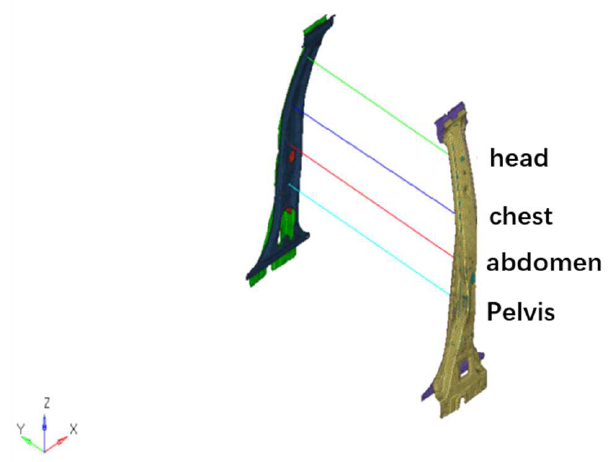
Figure 12. Measurement position of spring element of automobile B-pillar.